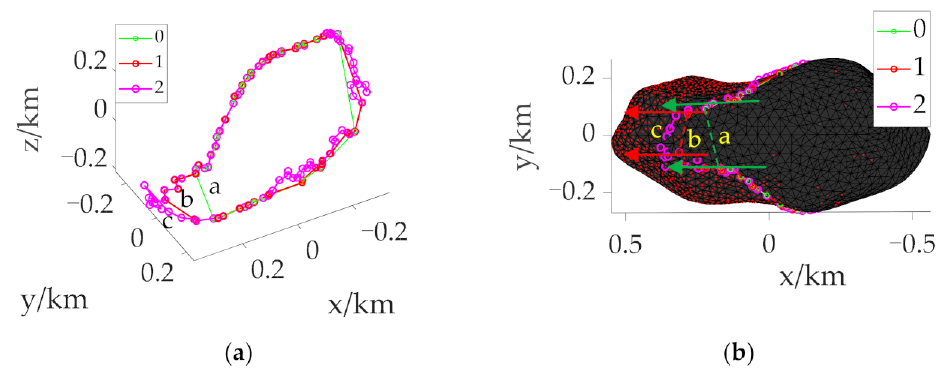
Figure 3. Use of the extension method. ( a ) The extension from the initial boundary to the continuous boundary. ( b ) The extension of the “a” part. “0” represents the initial boundary, and “1” and “2” represent the boundary obtained after the first and second expansion,